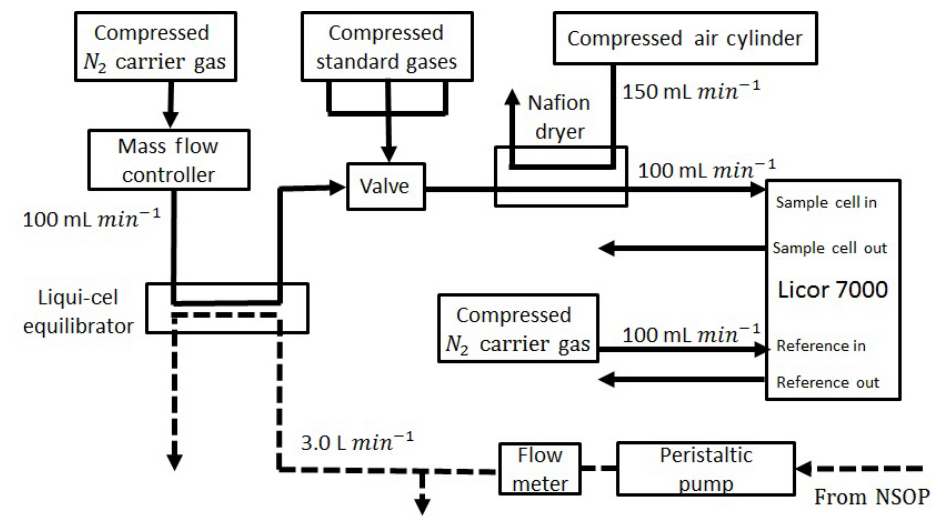
Figure 2. CO 2 system schematic. Solid and dashed arrows correspond to gas and water flows respectively. The LI-COR reference cell is flushed with equilibrated gas at 100mLmin − 1 . A manual selection valve was used to switch between equilibrated gas and the CO 2